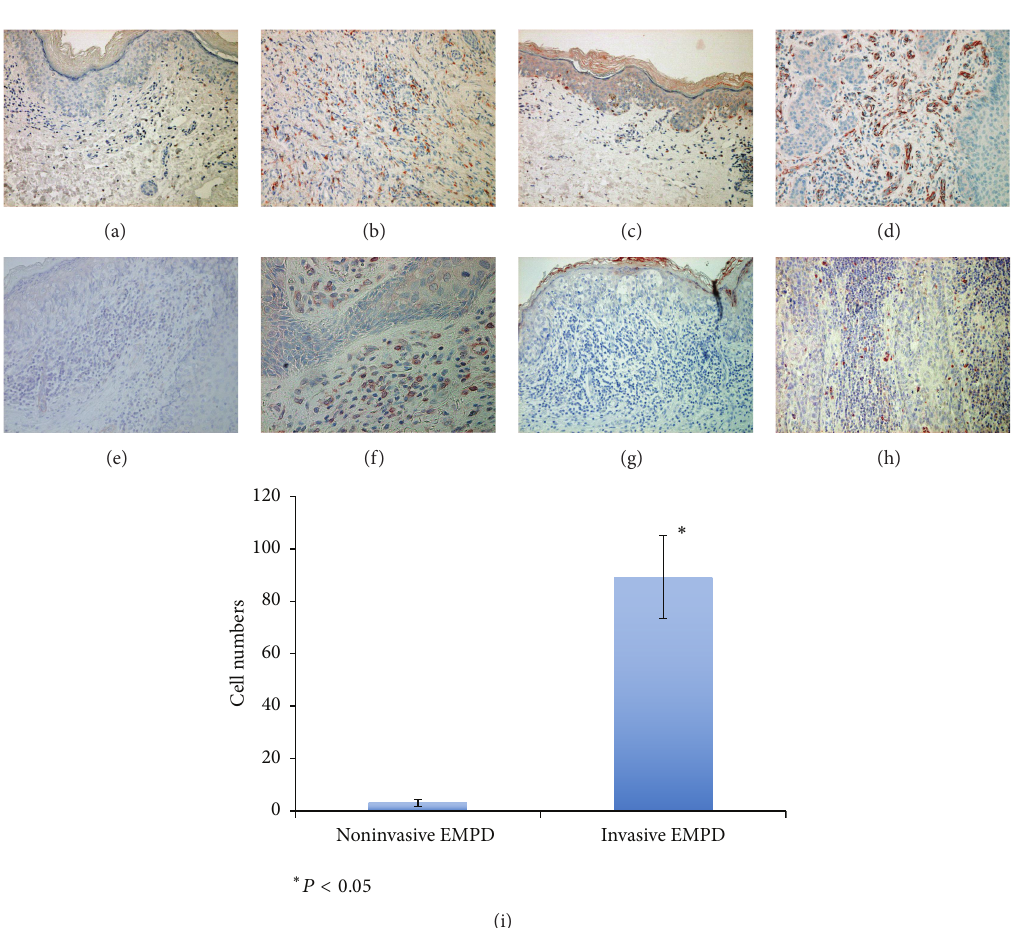
Figure 3: Anti-CD163, anti-MMP-9, anti-B7H1, and anti-ARG1 antibody staining of noninvasive and invasive EMPD. Paraffin-embedded tissue samples from patients with non-invasive EMPD ((a), (c), (e), and (g)) and invasive EMPD ((b), (d), (f), and (h)) were deparaffinized and stained with the anti-CD163 Ab ((a) and (b)), anti-MMP-9Ab ((c) and (d)), anti-B7H1-Ab ((e) and (f)), or anti-ARG1 Ab ((g) and (h)). Sections were developed with liquid permanent red. (CD163: staining for macrophages, MMP-9 staining, and B7H1 for macrophages and endothelial cells) ((a)–(e), (g) (h): × 200, (f): × 400). Five representative fields of each section were selected from each group of EMPD. The number of CD163 + cells in invasive and noninvasive EMPD was counted using an ocular grid of 1cm 2 at a magnification of 400x and summarized. The data are expressed as the means SD of the numbers in each area. Stars: 𝑃 < 0.05